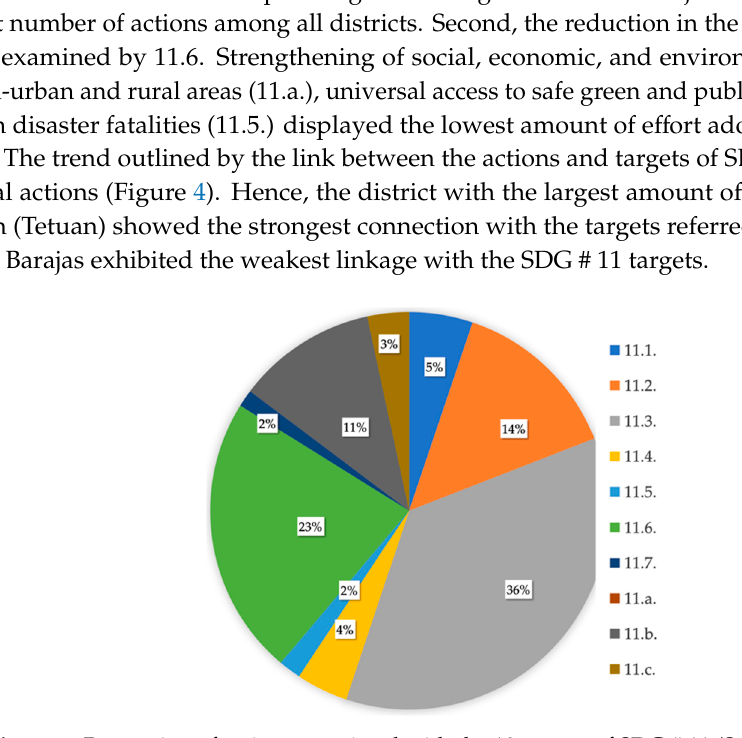
Table 5. Sharing of actions between targets of SDG # 11 (Source: author).